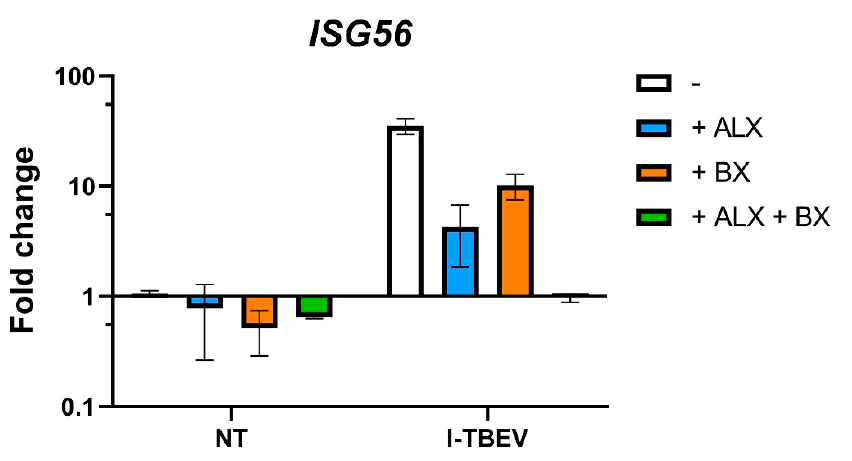
Figure A8. Assessment of the optimal concentration of RLR or MyD88 inhibitors in PBMCs. PBMCs from 3 healthy donors were pre-incubated with RLR inhibitors (ALX and BX) for 1 h ( A ) or with MyD88 inhibitor (Pepinh-MYD) and its peptide control (Control) for 6 h ( B ). Afterwards, the cells were treated for 24 h with Poly I:C (0.5 μ g/mL) or R848 (10 μ g/mL). Following stimulation, the cells were lysed and changes in gene expression were analyzed by RT-qPCR.